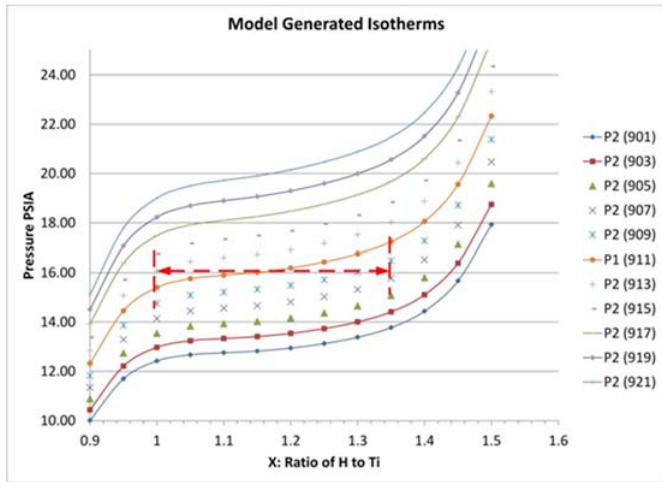
Figure 22. Model isotherms for a swing from TiH 1.0 –TiH 1.35 at 650 °C and 16.1 psia (1.1 atm).